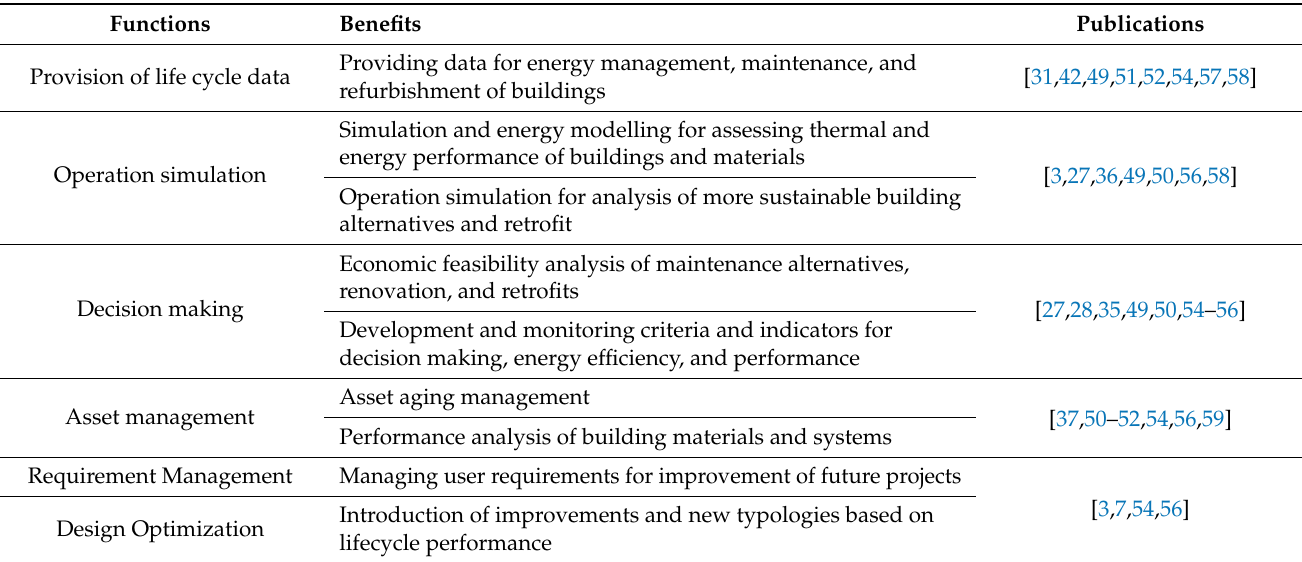
Table 5. Functions and benefits of using BIM for building maintenance and